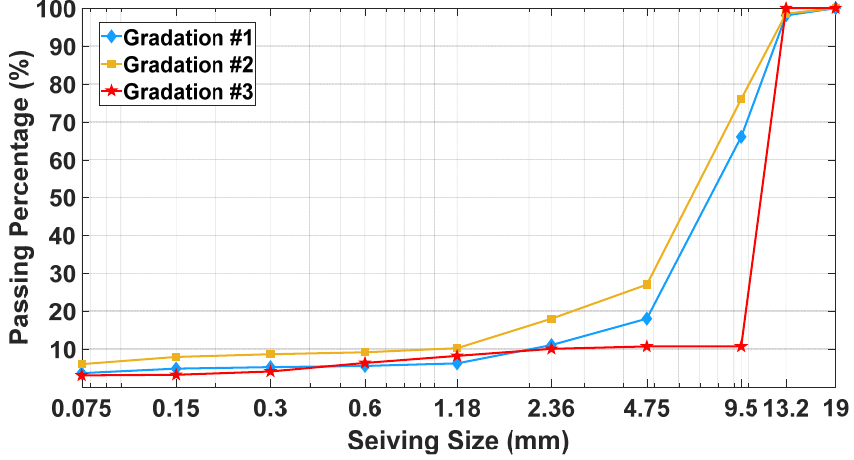
Figure 1. Gradation of open-graded asphalt mixture. Void ratios are 23%, 19% and 25% for #1, #2 and #3, respectively. #3,